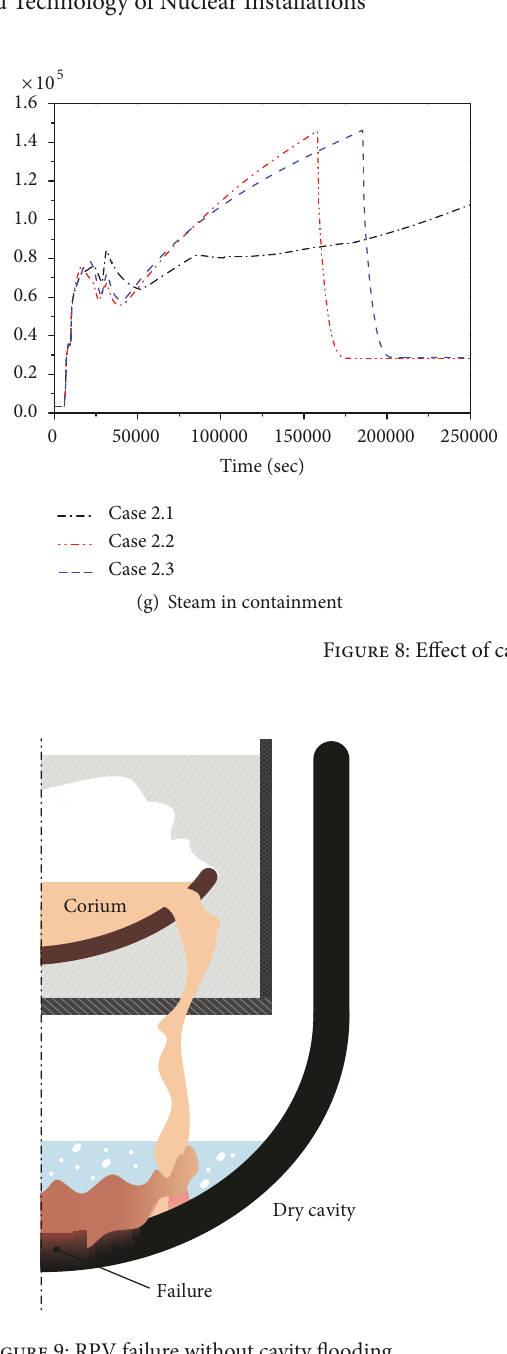
Figure 9: RPV failure without cavity flooding.